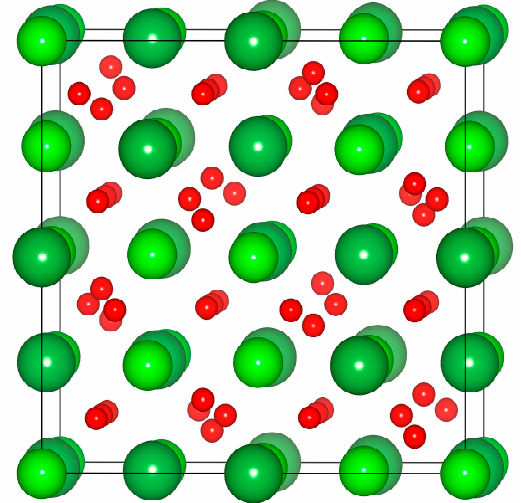
Figure 1. Schematic view of the geometrical structures of La 2 Zr 2 O 7 . The dark green, yellow-green, and red spheres represent La, Zr, and O atoms, respectively. Table 1. The calculated lattice constants a 0 (Å), O 48f position parameter x ( x O48f ), and bonding distances (Å) for La 2 Zr 2 O 7 and Pu 2 Zr 2 O 7 . E g represents the band gap; d<A-B>: bonding distances between A and B atoms (A = La, Pu, or Zr; B = O 48f or O 8b